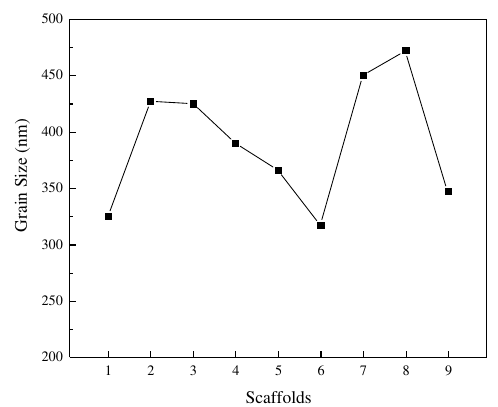
Figure 15. Effect of Energy Density on Grain Size.